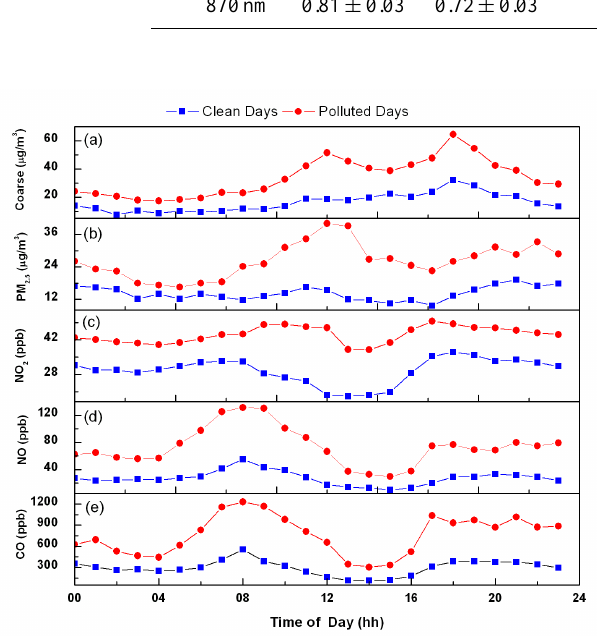
Fig. 4. Diurnal variation of hourly average concentrations of (a) coarse particles, (b) PM 2 . 5 , (c) ni tric oxide, (d) nitrogen dioxide, and (e) carbon monoxide.